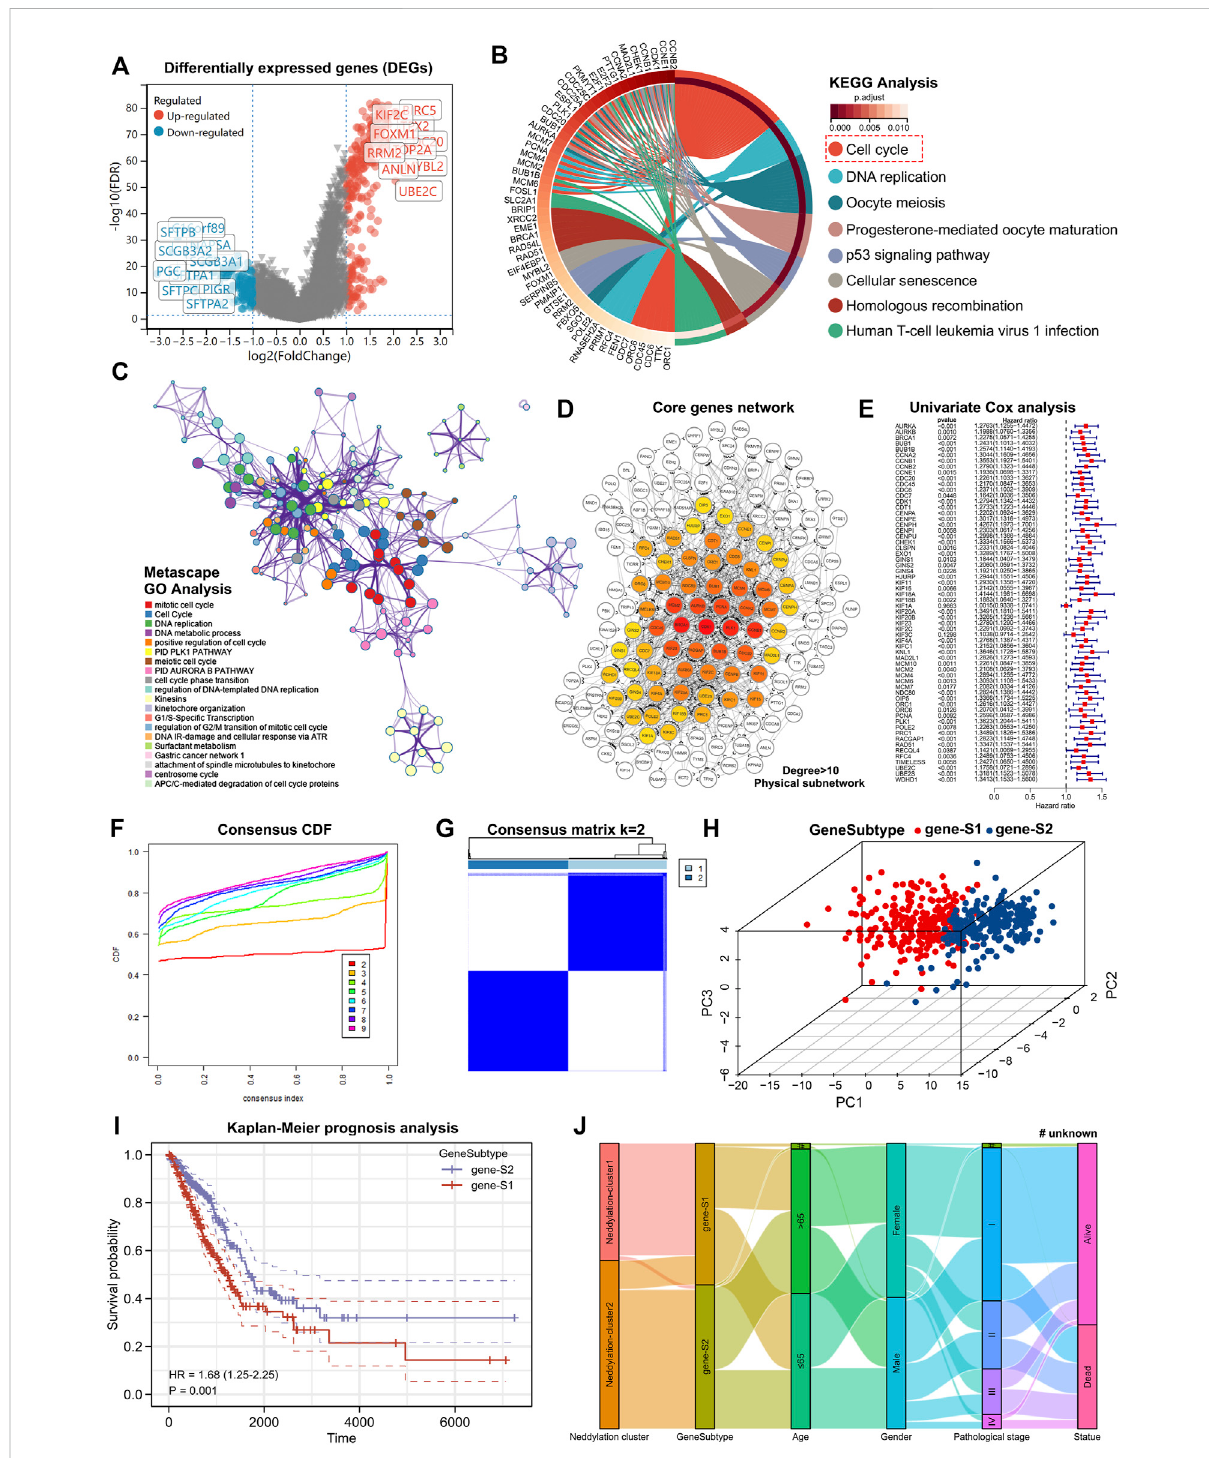
FIGURE 5 Identi fi cation of neddylation-associated gene subtypes based on differentially expressed genes. (A) Volcano map showed differentially expressed genes between two patterns (FDR < 0.05, |log2FC| > 1). (B) KEGG enrichment analysis of differentially expressed genes (FDR < 0.05, | log2FC| > 1). (C) GO enrichment analysis of differentially expressed genes (FDR < 0.05, |log2FC| > 1). (D) Construction of core gene network using STRING database and cytoscope software. (E) Univariate Cox analysis of core genes. (F,G) Consensus clustering based on core genes. (H) PCA of gene subtypes. (I) Prognostic differences between two gene subtypes. (J) Sankey diagram based on neddylation patterns, gene subtypes, age, gender, pathological stage, and survival